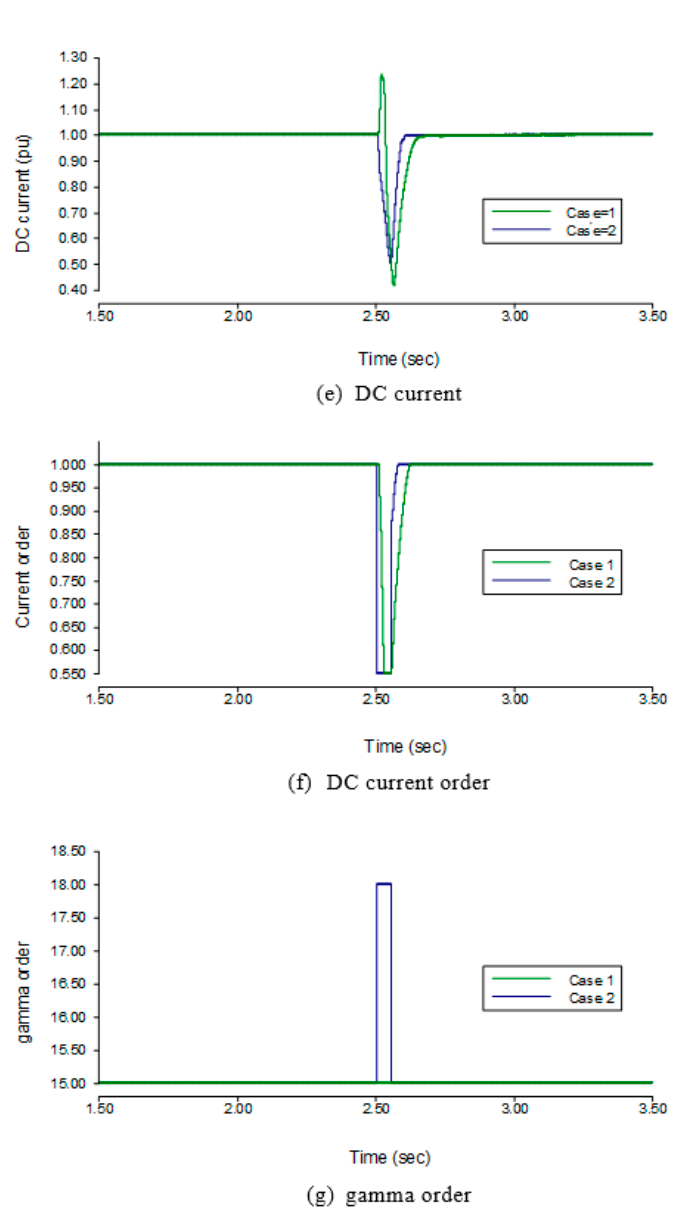
Figure 7. Transient state performance under single-phase to the ground with light AC fault.